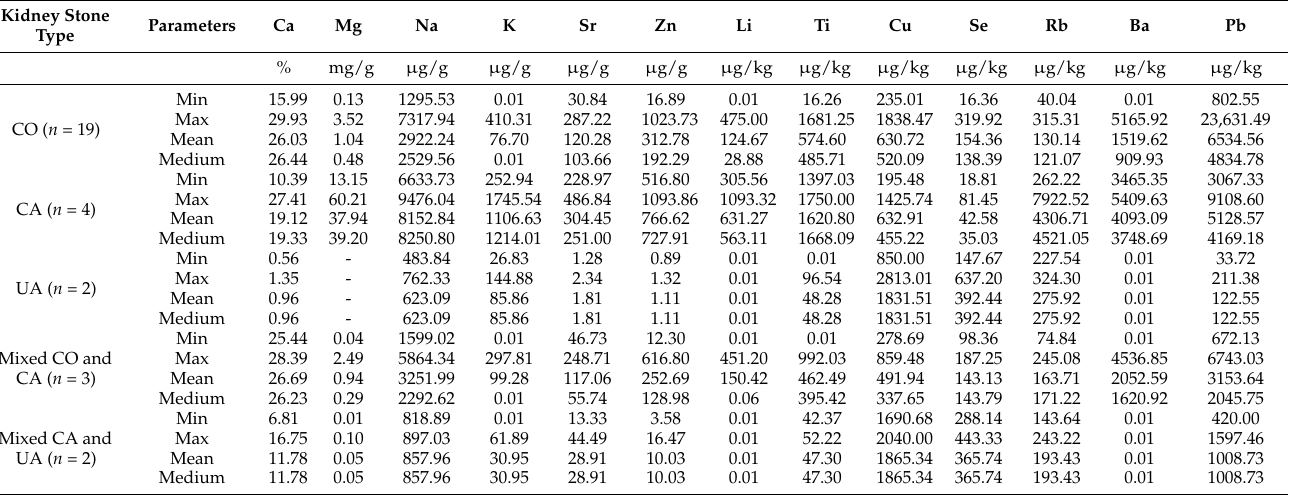
Table 1. Statistical results of major and trace elements in different kidney